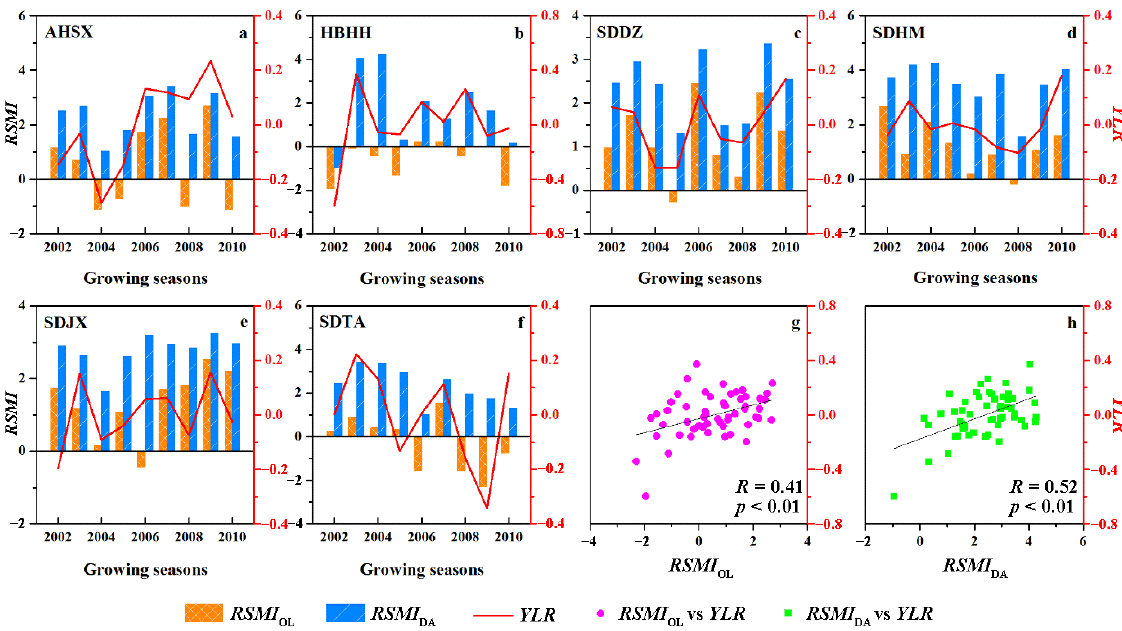
Figure 11. The relationship between the RSMI and yield loss ratio ( YLR ) during the growing seasons from 2002 to 2011: ( a – f ) the dynamics of RSMI and YLR at each site; ( g , h ) the scatter plots between RSMI and YLR at the six sites. RSMI OL , RSMI based on open-loop soil moisture; RSMI DA , RSMI based on assimilated soil moisture.